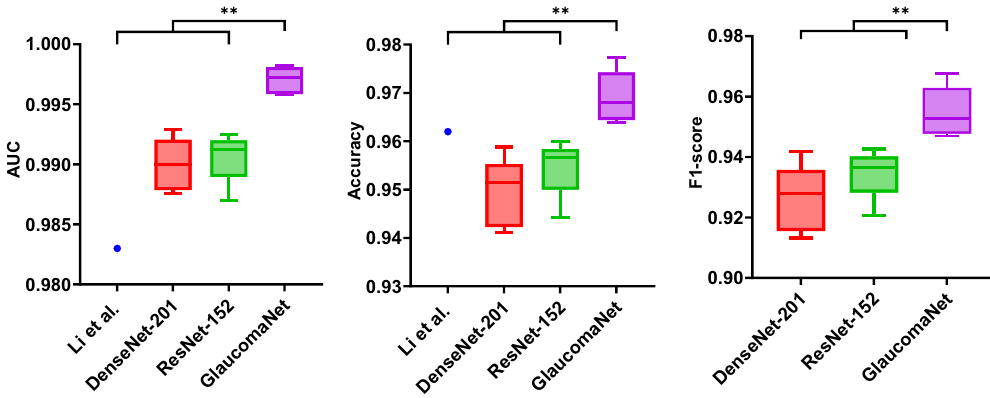
Figure 6. Comparison of different metrics for different model architectures in the LAG dataset. The model reported in Li et al. was trained on 10,928 images, with 4528 having POAG. There is no reported F1-score for Li et al. P-values are calculated between GlaucomaNet and other models. *p-value ≤ 0.05, **p-value ≤ 0.01.